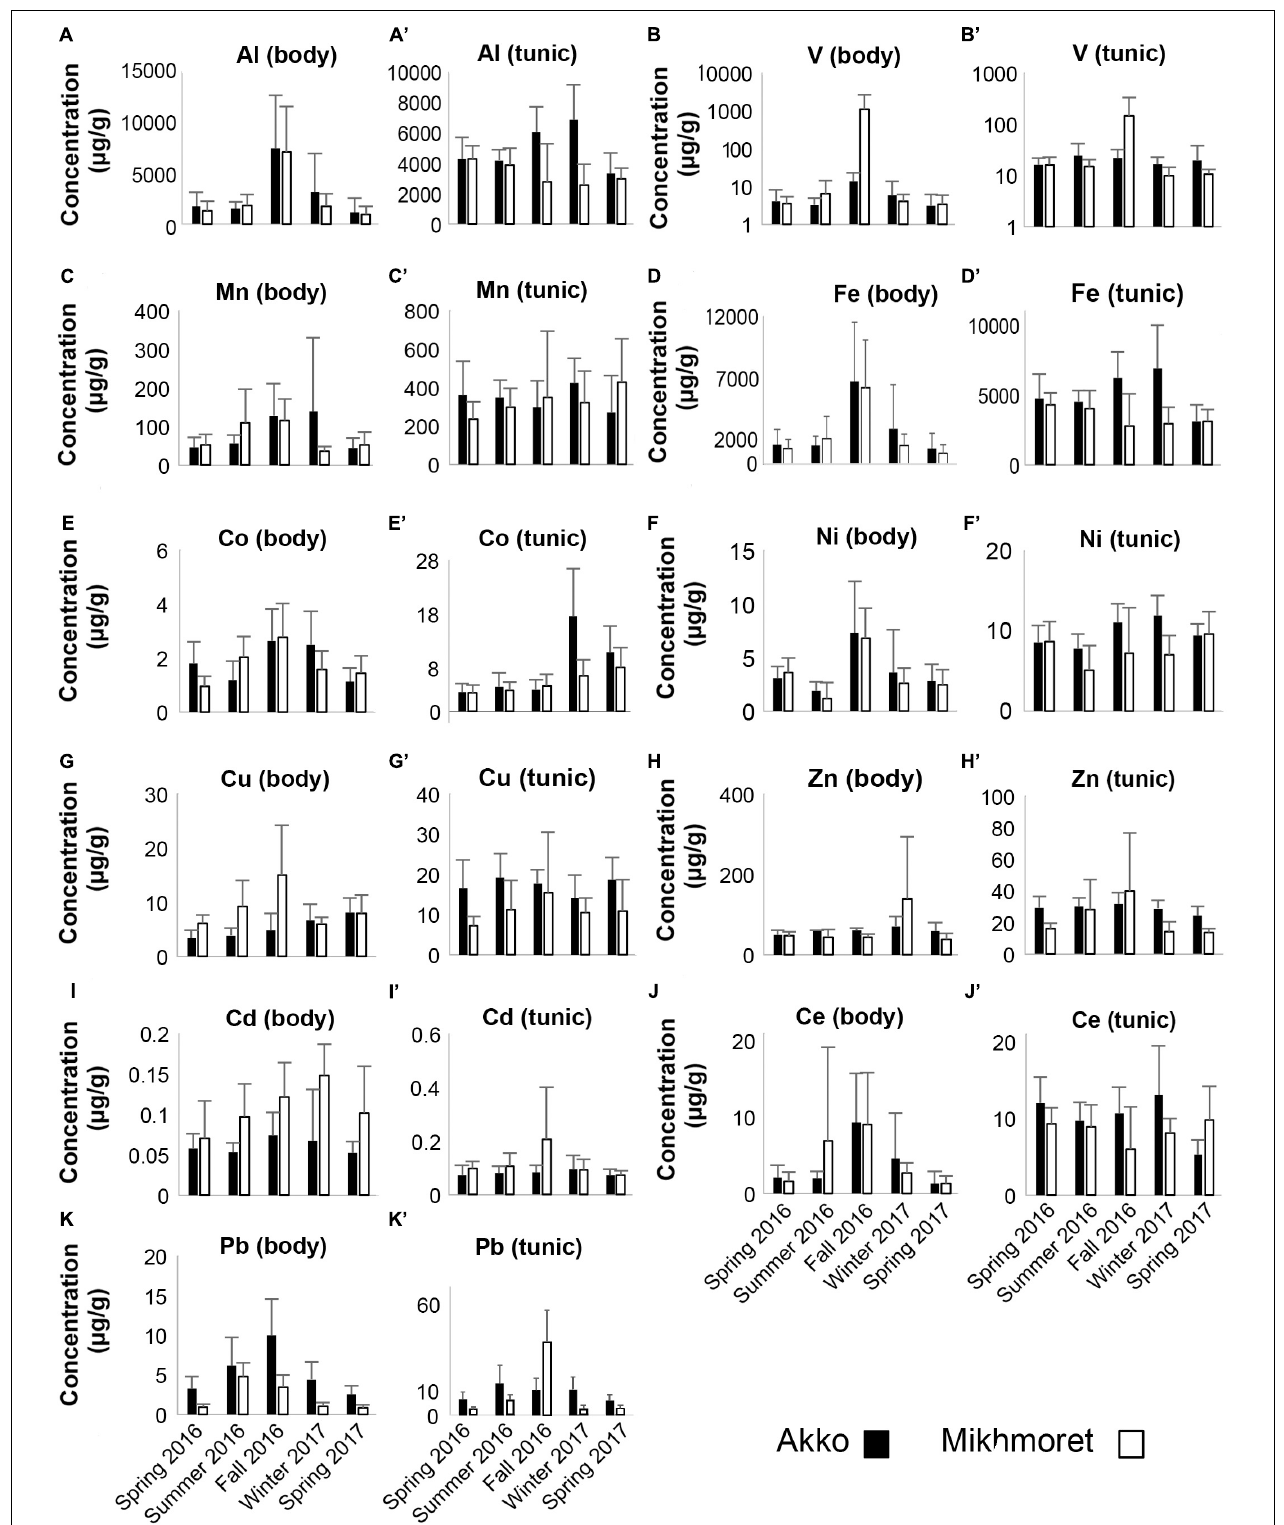
FIGURE 4 | Metal concentrations ( µ g/g) in the bodies (A–K) and tunics (A’–K’) of M. exasperatus , measured in the specimens sampled from Akko and Mikhmoret, during the different seasons of the study (Spring 2016–Spring 2017). Mean ( ± SD) is presented for all the metals, except for Co and Pb, for which ± SE is presented. Note that the V concentrations are presented on a logarithmic scale ( n =